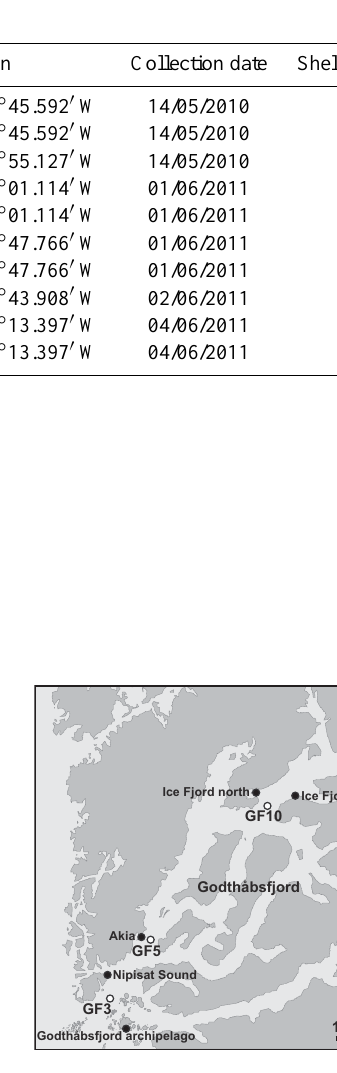
Table 1. Specifications of shell samples.